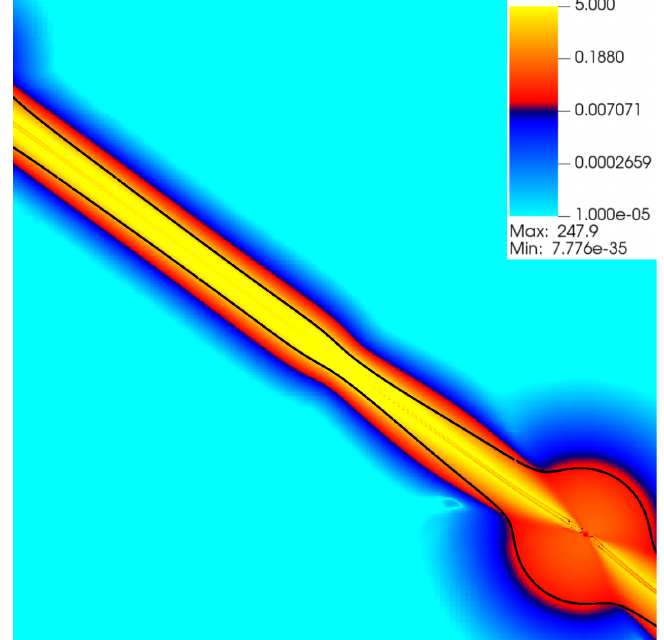
Figure 6 . Logarithm of the absolute value of the normalized Kretschamann scalar defined in the main text) for the last time slice of our 7 D simulation. Note that this quantity spans several orders of magnitude between the χ = 0 . 6 contour (black solid line) and the regions far away from